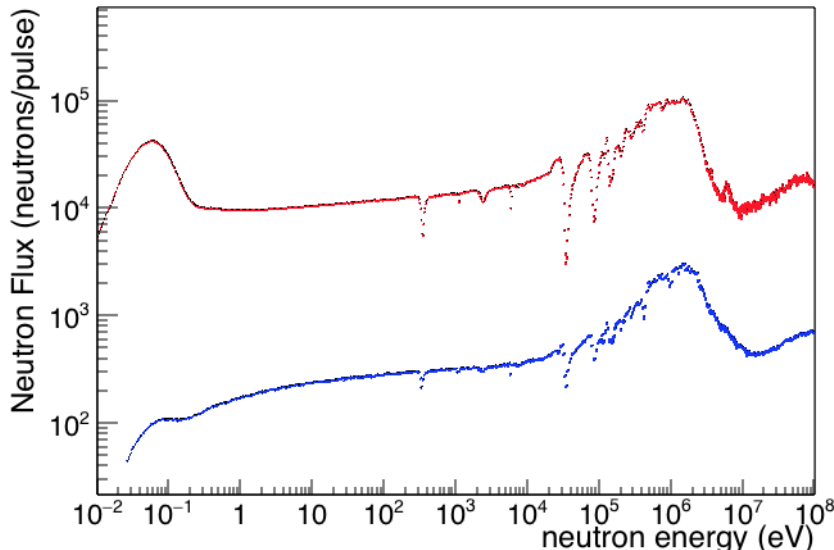
Figure 2. Energy distribution of neutrons reaching EAR1 and EAR2 at the sample position. Data from